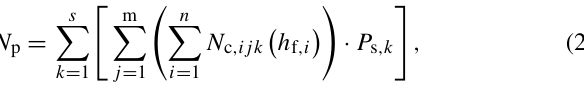
number of people